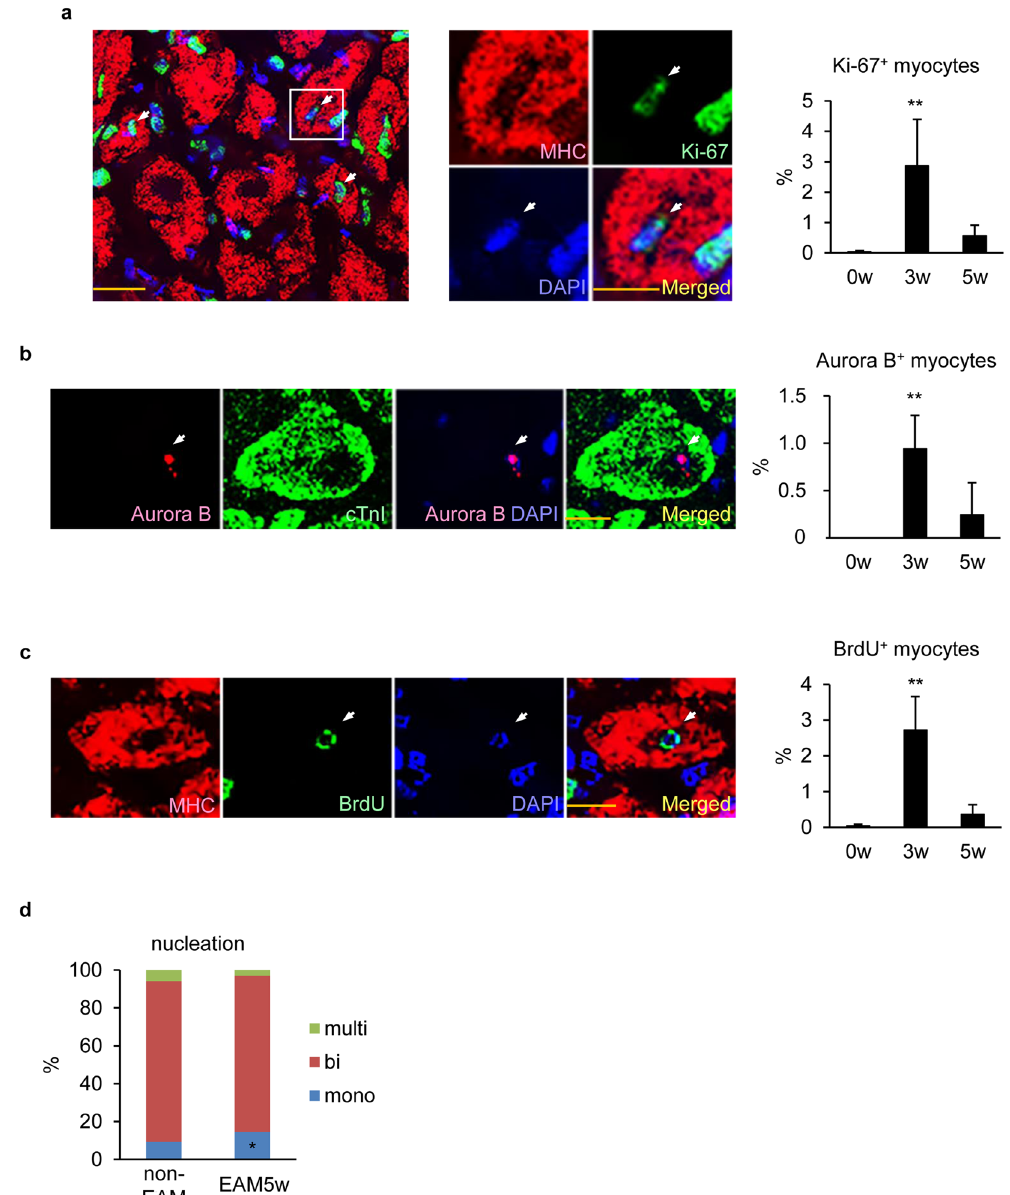
Figure 2. Cardiomyocytes positively stained with cell cycle markers were observed during EAM. ( a ) Heart sections were immunostained for Ki-67 and MHC at the indicated time points after EAM induction. Left: representative images of Ki-67 + MHC + cells at EAM3w are shown. Middle: magnified images of a Ki-67 + MHC + cell in the left panel. Arrows: Ki-67 + nuclei in MHC + cells. Scale bar: 20 μ m in the left panel and 10 μ m in the center panel. Right: Ki-67 + MHC + cells in the inflamed region were counted and shown as percentage in MHC + cells. n = 5 mice for each group. ( b ) Heart sections were immunostained for Aurora B and cTnI at the indicated time points after EAM induction. Left: representative images of an Aurora B + cTnI + cell at EAM3w are shown. Arrows: an Aurora B + nucleus in a cTnI + cell. Scale bar: 10 μ m. Right: Aurora B + cTnI + cells in the inflamed region were counted and shown as percentage in cTnI + cells. n = 5 mice for each group. ( c ) BrdU was intraperitoneally injected four times at the indicated time points after EAM induction. Heart sections were immunostained with anti-BrdU and anti-MHC antibodies 24 hours after the last injection. Left: representative images of a BrdU + MHC + cell at EAM3w are shown. Arrows: a BrdU + nucleus in a MHC + cell. Scale bar: 10 μ m. Right: BrdU + MHC + cells in the inflamed region were counted and shown as percentage in MHC + cells. n = 5 mice for 0w and 5w; 4 mice for 3w. ( d ) Cardiomyocytes were isolated from EAM5w hearts or from age-matched non-EAM hearts and stained with anti- α -actinin antibody and DAPI. A total of 1243 cardiomyocytes from 4 non-EAM hearts and 2330 cardiomyocytes from 7 EAM5w hearts were classified according to the number of nuclei. ( a – c ) Kruskal-Wallis test. ** P < 0.01 vs 0w. ( d ) Welch’s t -test. * P < 0.05 vs non-EAM. Data are shown as mean ±